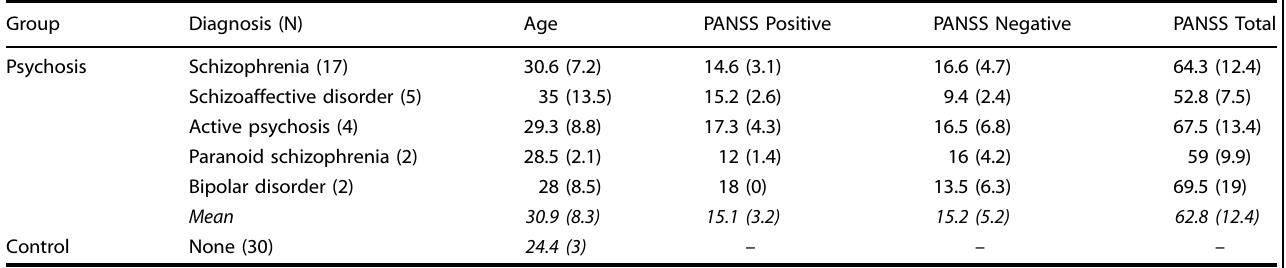
Table 2. Participants ’ demographic and clinical